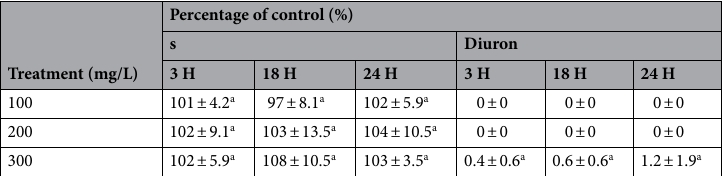
Table 4. Quantum yields of leaf discs of Oldenlandia verticillata after treatments of compound c and diuron. Data indicate the mean ± standard deviation of six replicates. *Means followed by similar small letters within the same row have no significant differences ( p > 0.05) among incubation periods within compound c or